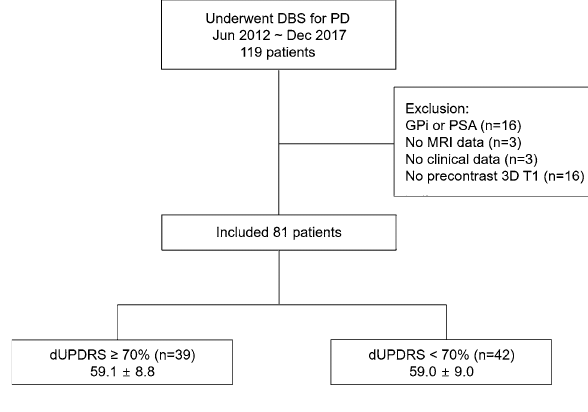
Figure 1. Patient flowchart.